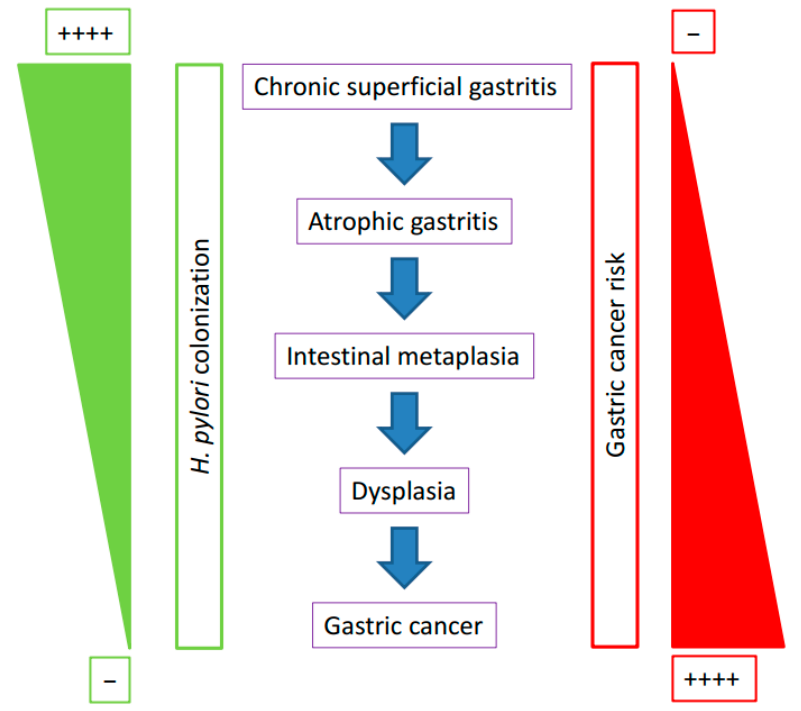
Figure 1. Opposite trends for H. pylori density and noncardia gastric cancer risk in relation to the histopathological changes in the human gastric mucosa.